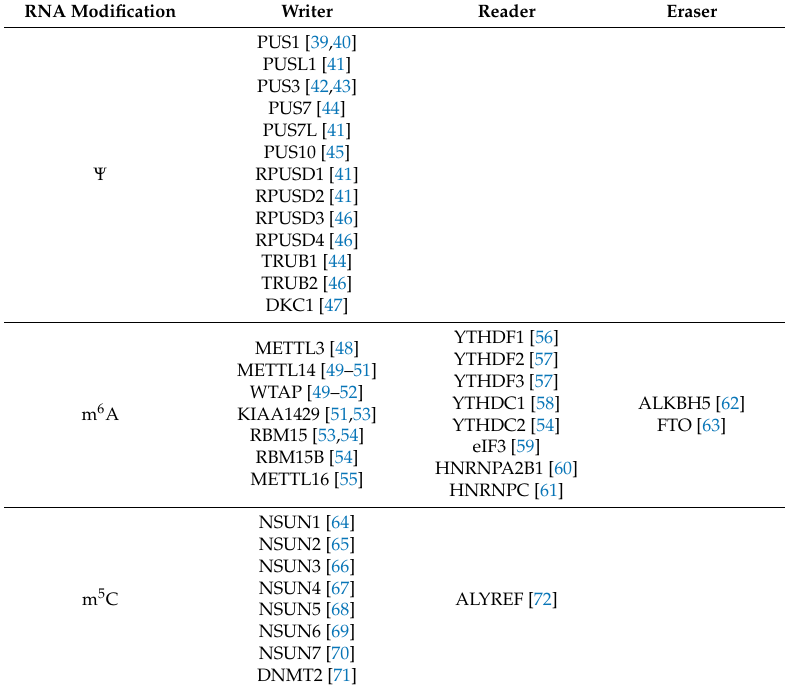
Table 1. Known writer, reader, and eraser proteins for chemical RNA